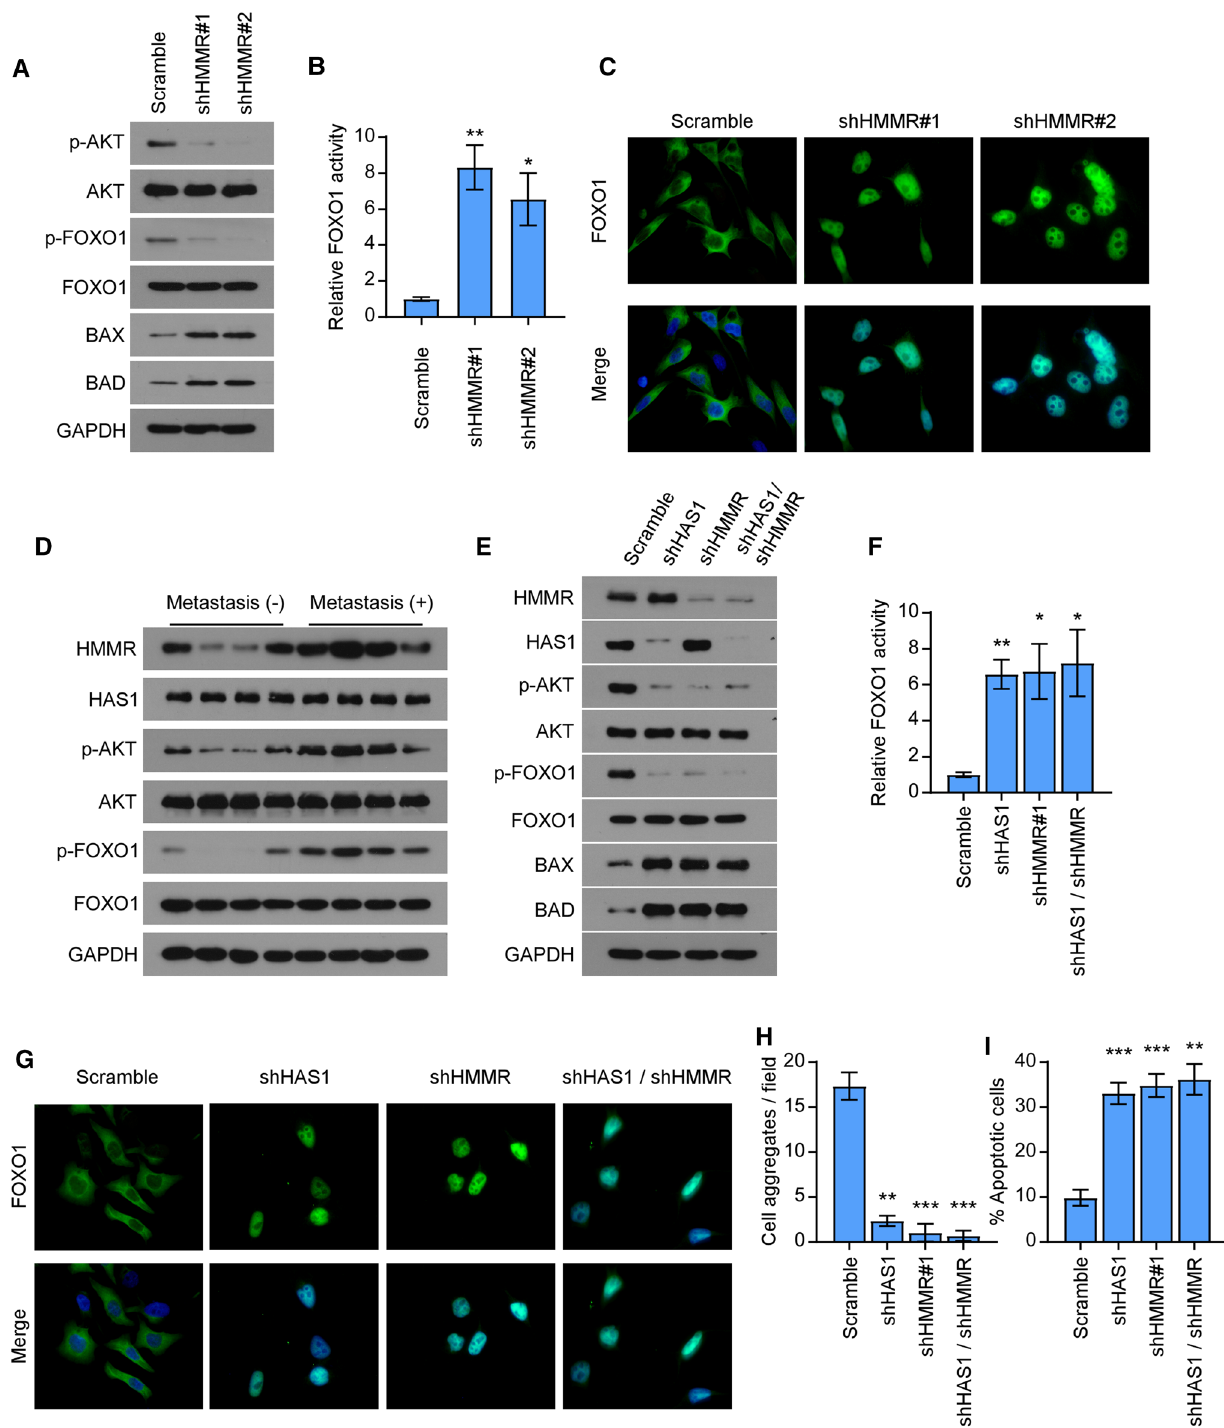
Fig. 3 HA-HMMR axis activates AKT signaling. A Immunoblot analyses the expression of critical genes of AKT/FOXO1 signaling pathway (p-AKT, AKT, p-FOXO1, FOXO1, BAX, BAD) in indicated groups. GAPDH was used as a loading control. B Luciferase reporter assay showed the transcriptional activity of FOXO1 in control and HMMR-silencing AGS cells. C The immunofluorescence (IF) staining of FOXO1 was performed in indicated groups. D Immunoblot analysis of HMMR, HAS1, p-AKT, AKT, p-FOXO1 and FOXO1 in patients with or without peritoneum metastasis. GAPDH was used as a loading control. E Immunoblot analysis of HMMR, HAS1 and critical genes of AKT/FOXO1 signaling path- way (p-AKT, AKT, p-FOXO1, FOXO1, BAX, BAD) were performed in indicated groups. F Luciferase reporter assay showed the transcriptional activity of FOXO1 in indicated groups. G The immunofluorescence (IF) staining of FOXO1 was performed in indicated groups. H Quantifica- tion of cell aggregates formation for the indicated groups. I Quantification of anoikis cells in the indicated groups. Each bar represents the mean ± SD of three independent experiments. P < 0.05 was considered statistically significant. * P < 0.05; ** P < 0.01; *** P <